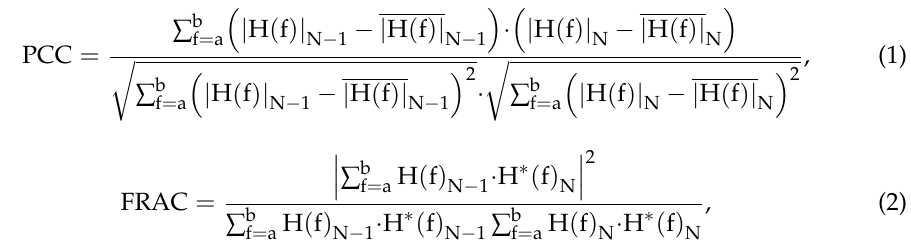
Figure 3. Illustration of setup for the femur–implant structure with artificial soft tissue and meas- urement procedure, where the excitation hammer and accelerometer are visible. 2.4. Comparative Test –Pre and –Post Soft Tissue Addition For the third experiment, in order to determine the influence of the artificial soft tis- sue on the obtained FRFs, a measurement was taken with and without soft tissue, without altering the implanted femur structure in any way between the two measurements, other than the addition of the soft tissue. The obtained FRFs for the AP and ML measurement directions were compared and the damping ratio percentage ζ determined using the signal processing software (Simcenter LMS Test.Lab, Siemens PLM) for the most prominent peaks on the FRF, in order to illustrate the influence of the soft tissue on the amount of damping. 𝜁 (cid:4670)%(cid:4671) = (cid:2869) (cid:2870) ∙ (cid:3057)(cid:3104) (cid:3119)(cid:3279)(cid:3251) (cid:3104) (cid:3342) ∙ 100 , (3) where 𝜔 (cid:3094) is the resonant frequency and 𝛥𝜔 (cid:2871)(cid:3031)(cid:3003) is the difference in frequency between the values that correspond to amplitudes of 3dB less than the amplitude at the resonant frequency peak, at the left and right side of that resonant frequency.